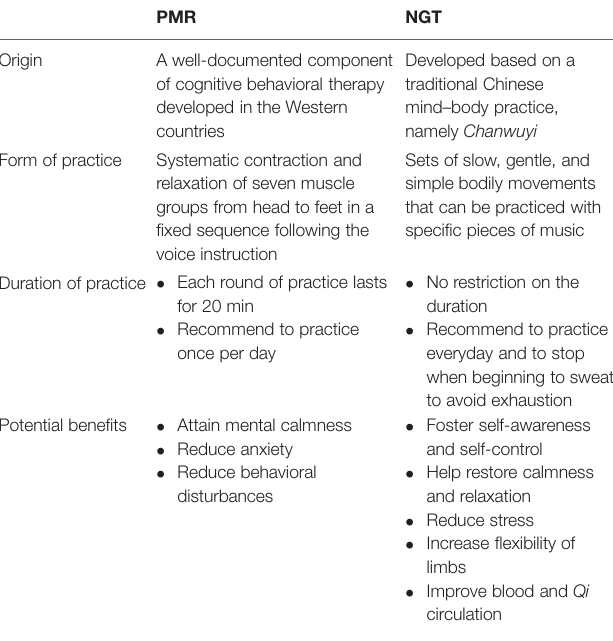
TABLE 2 | Comparison between progressive muscle relaxation and Nei Gong training. PMR